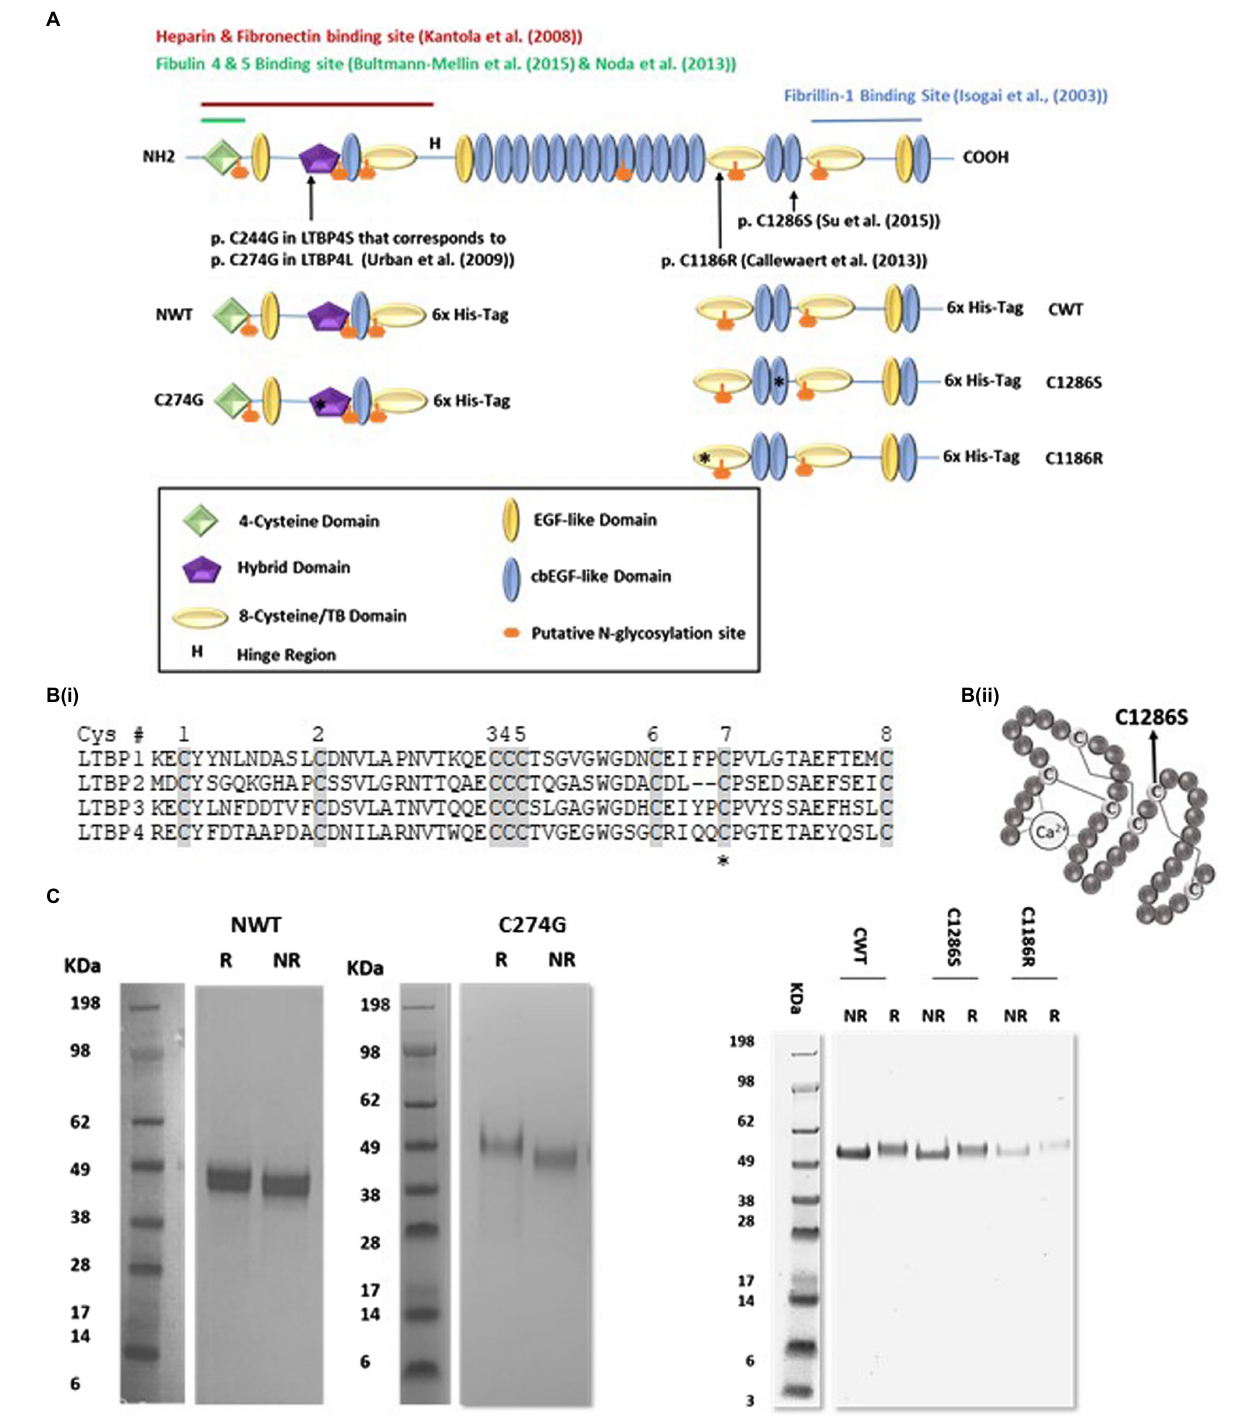
FIGURE 1 | Expression and purification of recombinant latent TGF β binding protein-4 (LTBP4). (A) Schematic diagram of the domain organisation of full-length human LTBP4S with interaction sites indicated and the LTBP4 constructs with 6x-His-tag used in this study. Arrows and asterisks indicate the positions of the ARCL1C mutations. (B) (i) Amino acid sequence of the second TB domain in LTBP1-4 with the eight conserved cysteine residues shaded. C1186 is the C7 residue (highlighted with an asterisk), involved in an intramolecular disulphide bond. C2 and C6 are involved in the interaction with TGF β -LAP. (ii) Schematic diagram of a representative cbEGF domain with conserved cysteine residues labelled and disulphide bonds illustrated by lines. The position of the substituted cysteine, C1286, C5 is indicated by an arrow. (C) SDS-PAGE of the purified LTBP4 N- and C-terminal constructs: NWT, C274G, CWT, C1286S and C1186R under reducing (R) and non-reducing (NR)